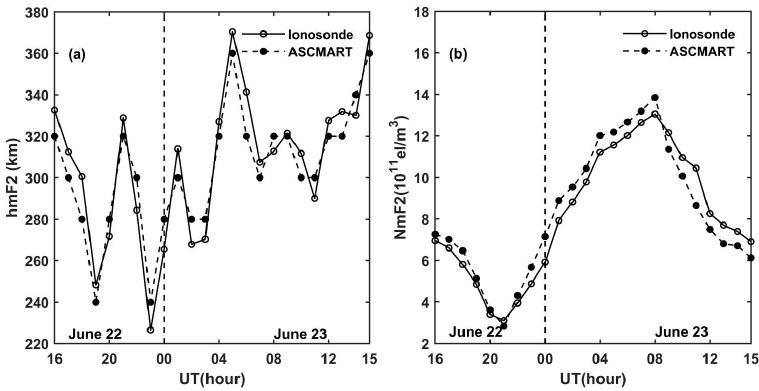
Figure 12. Comparisons of ( a ) the hmF2 and ( b ) NmF2 from the ASCMART with those obtained from the ionosonde located at Shaoyang on 22 and 23 June 2015.